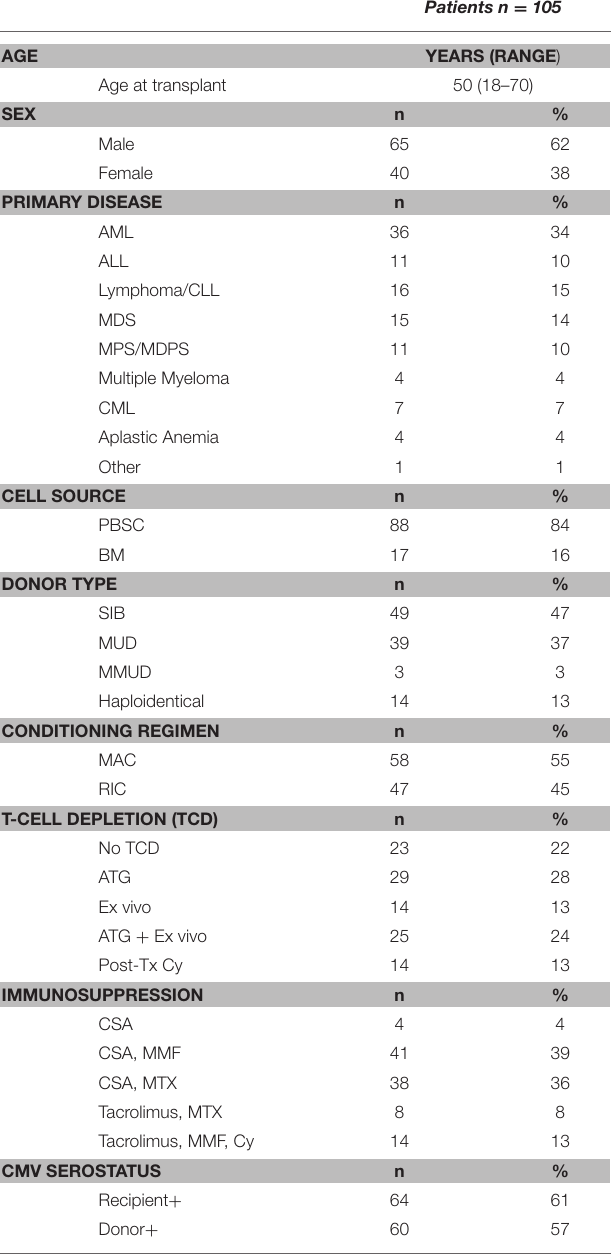
TABLE 1 | Clinical characteristics of HSCT